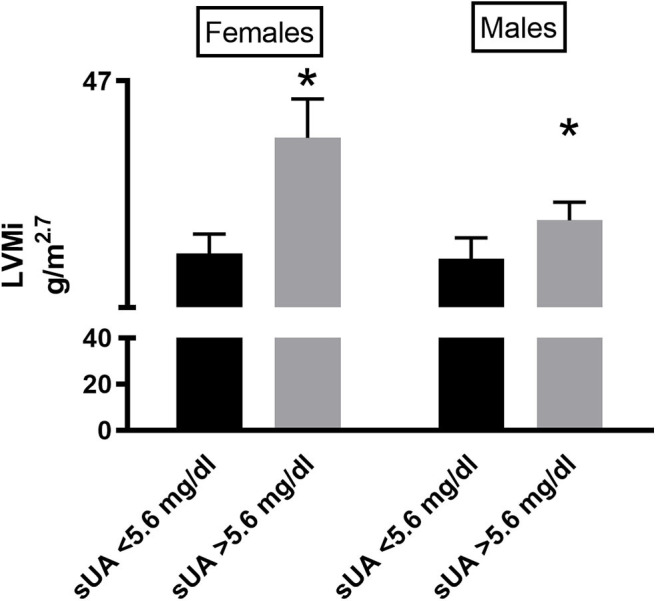
LVMi in female (left graph) and male (right graph) patients according to sUA ≤5.6 or sUA >5.6 mg/dl (right graph). The graph shows a higher value of LVMi in hypertensives with Sua >5.6 mg/dl (p < 0.05), independent from gender. *Indicates p < 0.05.